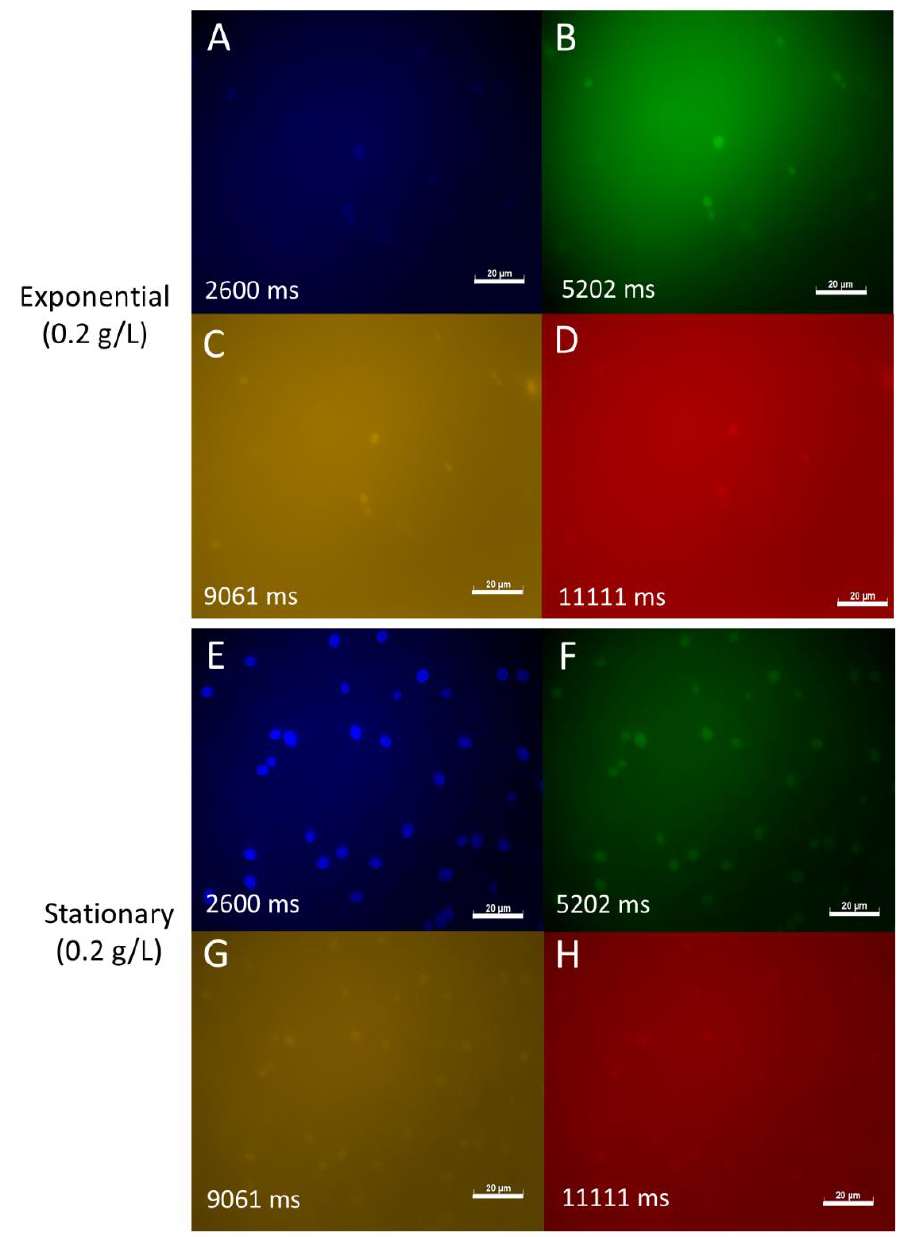
Figure 3. Autofluorescence of S. dacryoidea grown in the oligotrophic medium and sampled in the exponential and stationary phase. ( A , E ): DAPI channel; ( B , F ): FITC channel; ( C , G ): DsRed channel; ( D , H ): rhodamine channel. Picture exposure times are depicted in milliseconds (ms). Scale bar = 20 µm.